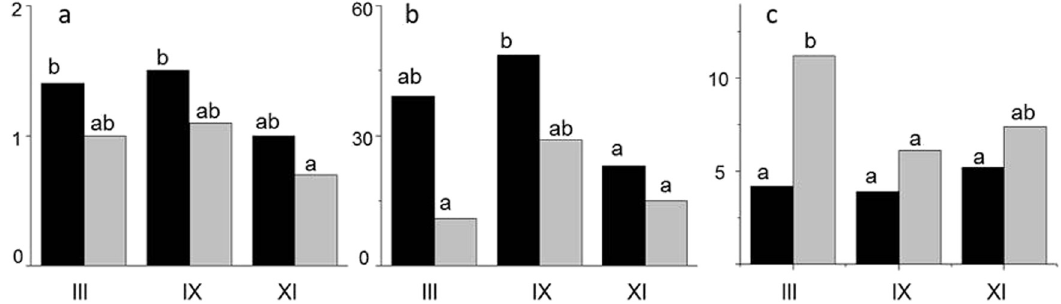
sugar ( black column ) or with sugar and algarrobo fl our ( grey column )